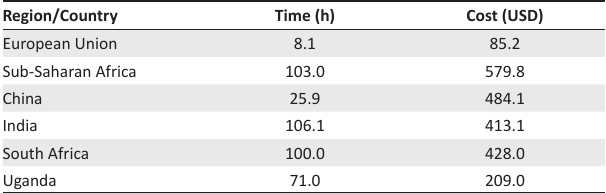
TABLE 1: Time and cost to export, border